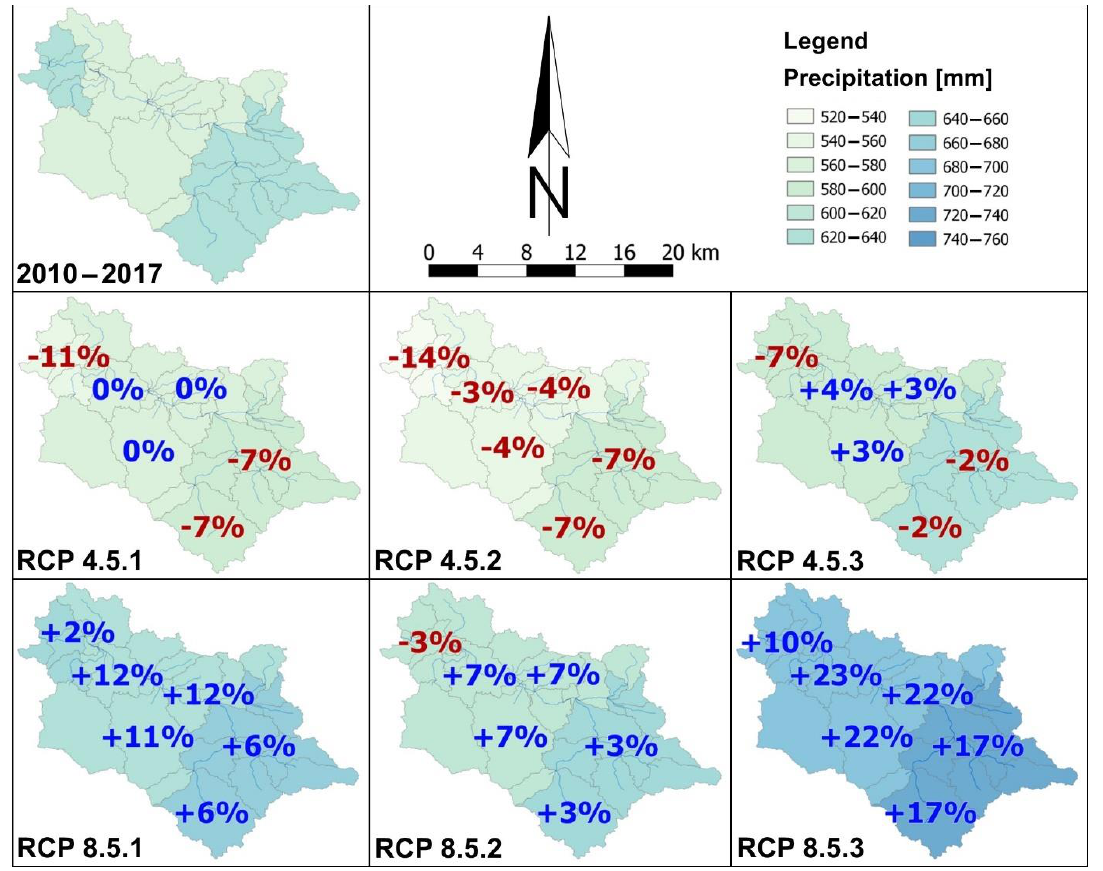
Figure 10. Comparison of the average annual sum of precipitation in 31 sub-catchments for the SWAT simulation period for 2010–2017 and 2041–2050 for individual climate projections in the RCP 4.5 and RCP 8.5 scenarios (own study).